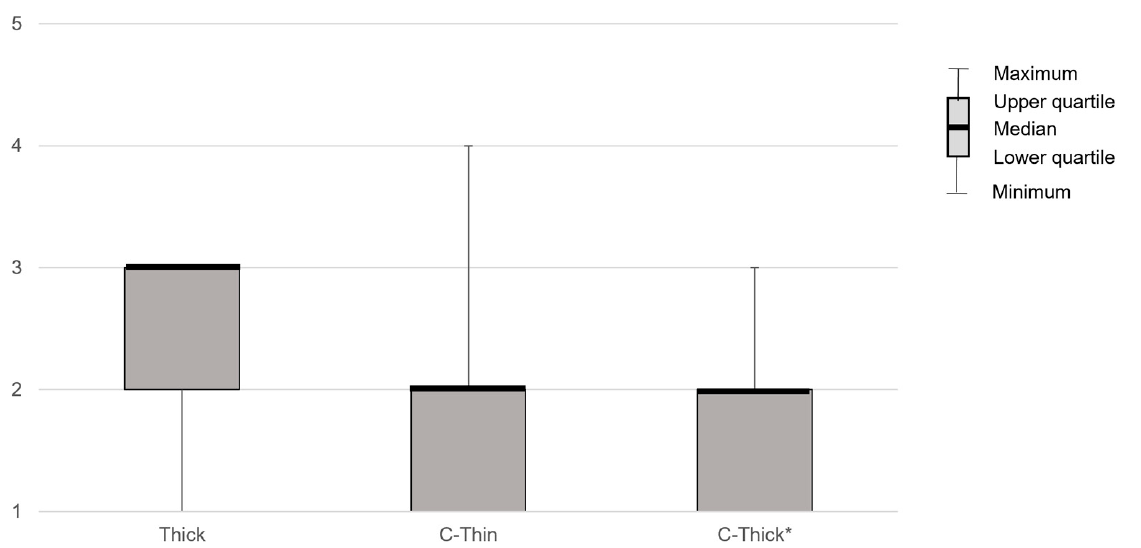
Figure 3. The patient’s subjective difficulty of swallowing compared to thin liquid. Thin, thin